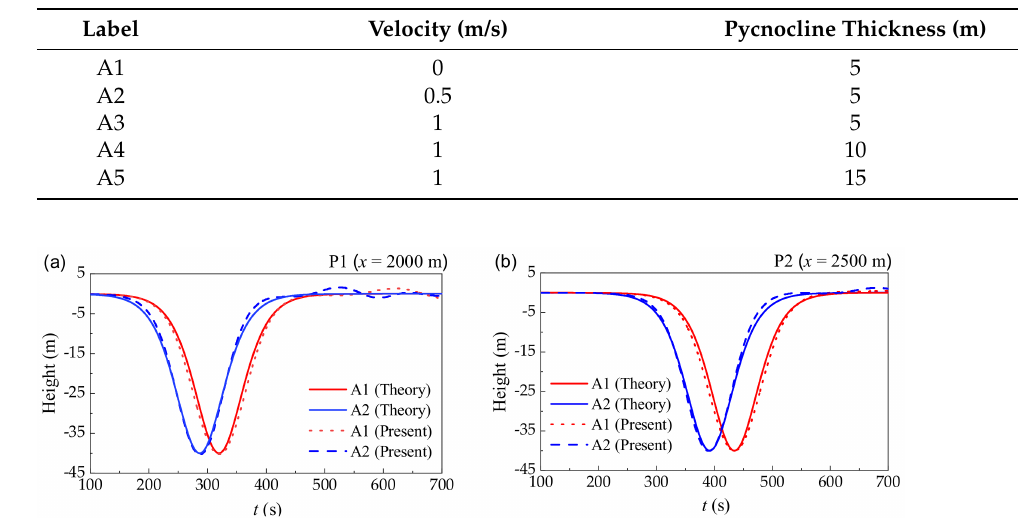
Figure 6. Time series of the wave height for Cases A1 and A2 at: ( a ) P1; ( b ) P2.